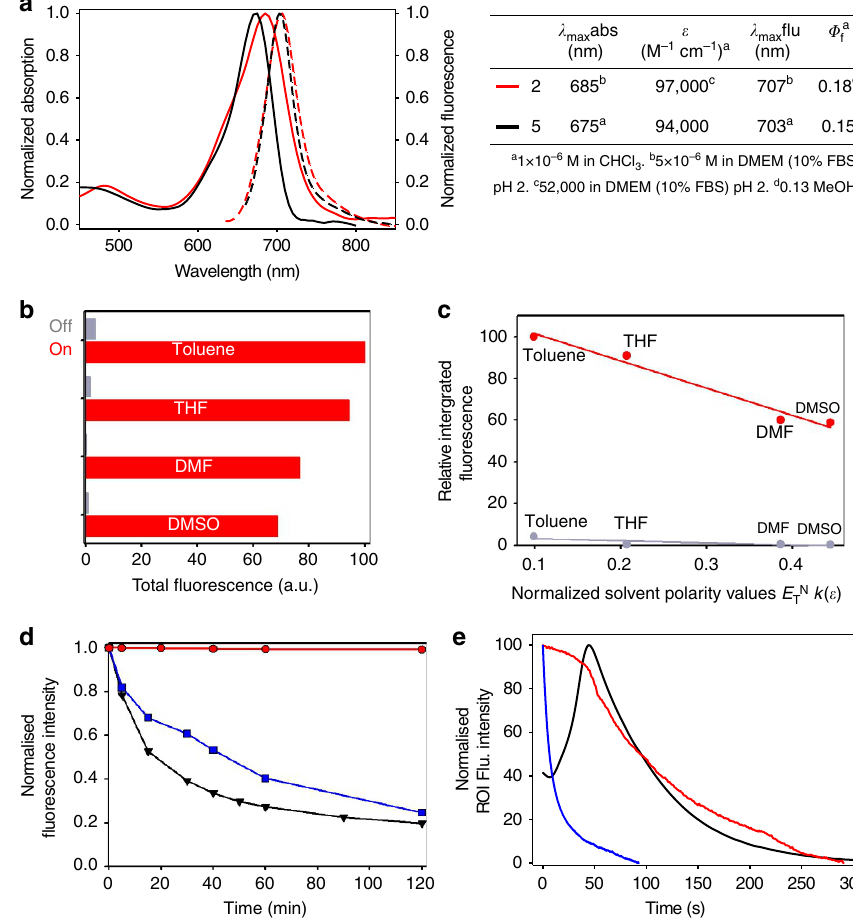
Figure 3 | Photophysical properties of NIR-fluorophores. ( a ) Light absorption and emission spectra of compounds 2 and 5 , and their photo-physical parameters. ( b ) Integrated off and on fluorescence states of 2 (5 (cid:3) 10 (cid:2) 6 M) in toluene, tetrahydrofuran (THF), dimethylformamide (DMF) and DMSO with TFA (red bars) and DBU (grey bars). ( c ) Plot of relative off and on integrated fluorescence versus solvent polarity values for toluene, THF, DMF and DMSO. ( d ) Comparative photobleaching of 1 (cid:3) 10 (cid:2) 7 M DMEM solutions of 2 (red line), lysotracker red (blue line) and pHrodo red (black line) with 150W fibre optic delivered light 620(30)nm for 2 and 540(40)nm for lysotracker red and pH-rhodo red at 25 (cid:2) C. ( e ) In vitro photobleaching of 2 (red), lysotracker red (blue line) and pHrodo red (black line) with maximum LED power using excitation filter 640(14)nm for 2 and excitation filter 563(9)nm for lysotracker red and pH-rhodo